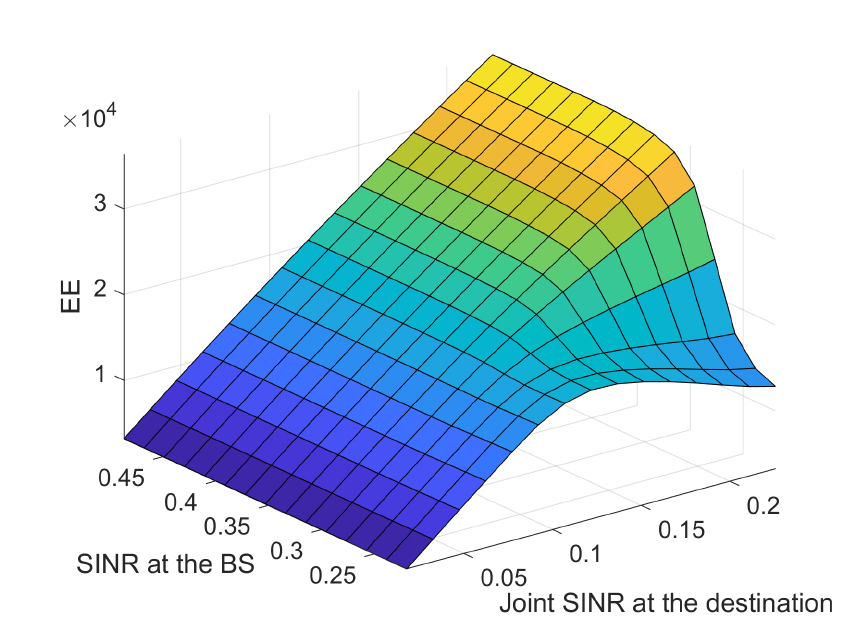
Figure 8. The surface viewer of ANFIS after